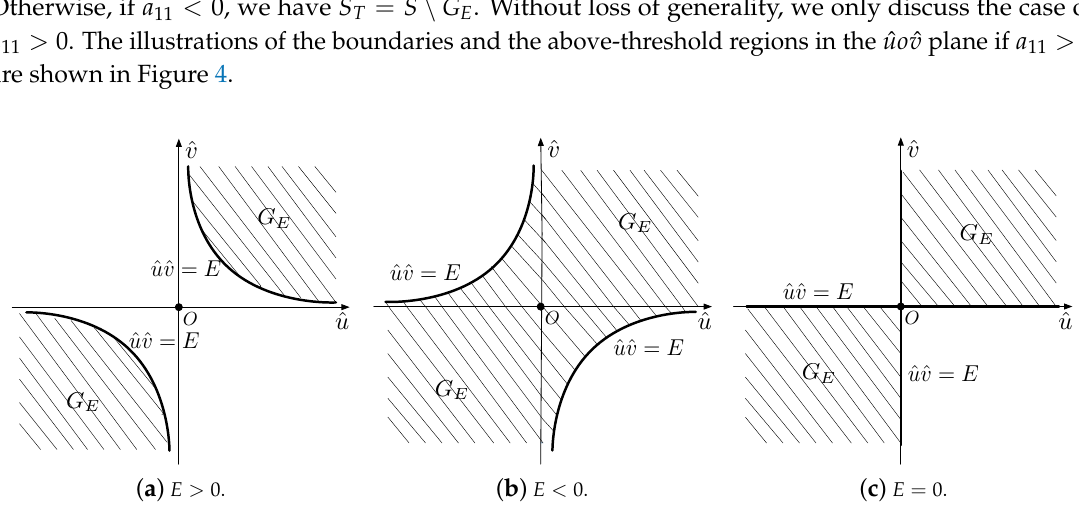
Figure 4. Illustrations of the boundaries and the regions G E in the ˆ uo ˆ v plane if a 11 >